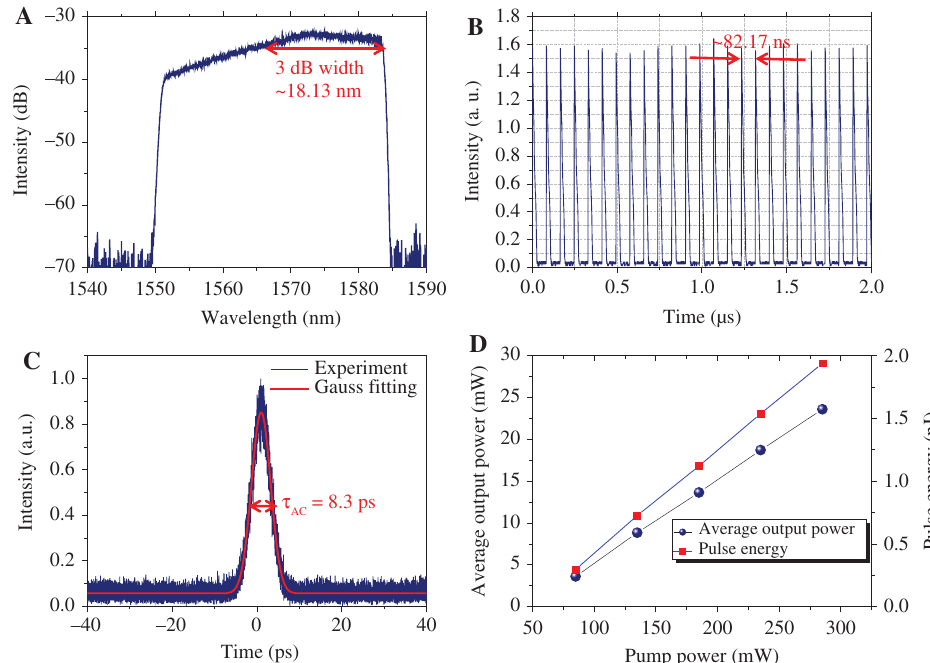
Figure 8: Output characteristics of tellurene-based SA mode-locked operation under the maximum pump power of 285 mW. (A) Emission optical spectrum. (B) Recorded pulse train. (C) Measured and fitted autocorrelation traces. (D) Out average output powers and pulse energies under different pump